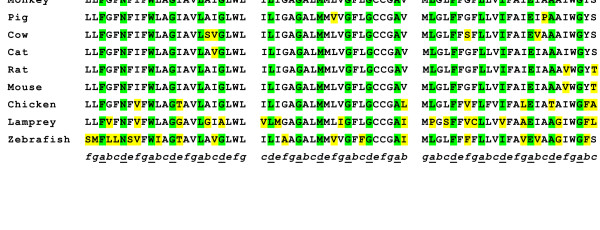
Sequence alignment of TM1-3 for ten vertebrate orthologs of CD9. Heptad positions a and d in TM1, TM2 and TM3 are highlighted in green. Residues that differ between orthologs are shown in yellow.